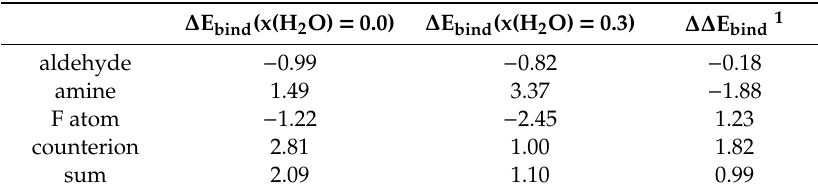
Table 1. Analysis of the binding energy di ff erence between TS- R -A − and TS- S -A − in the two solutions, x(H 2 O) = 0.0 and x(H 2 O) = 0.3 (in kcal /